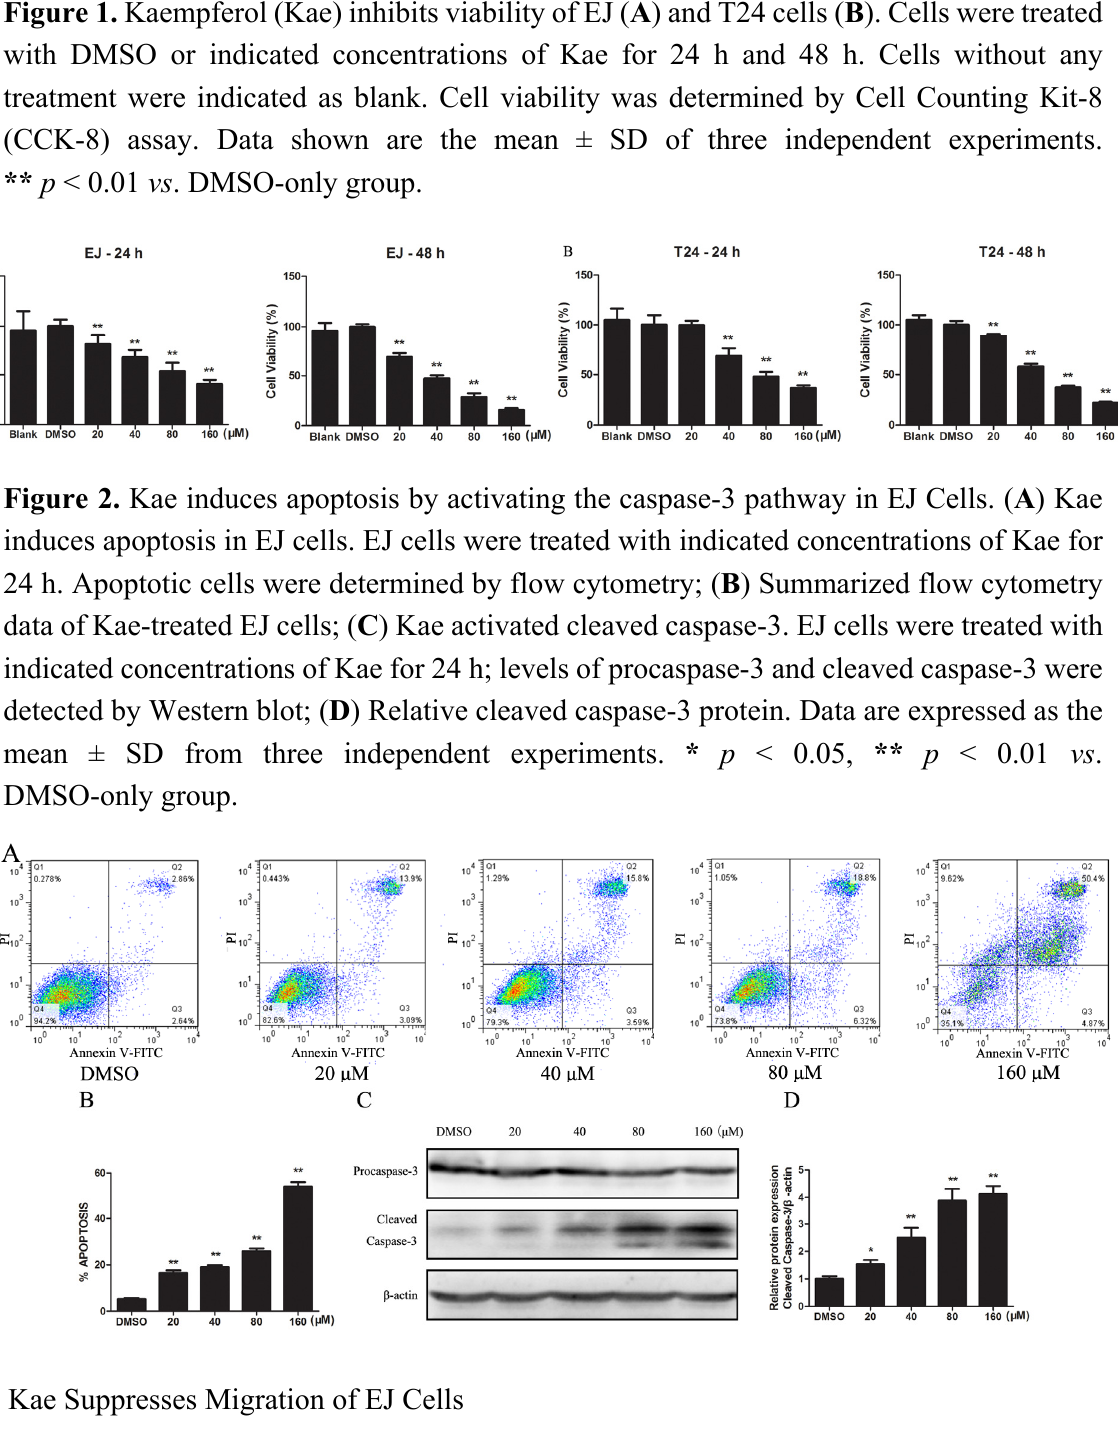
Figure 1. Kaempferol (Kae) inhibits viability of EJ ( A ) and T24 cells ( B ). Cells were treated with DMSO or indicated concentrations of Kae for 24 h and 48 h. Cells without any treatment were indicated as blank. Cell viability was determined by Cell Counting